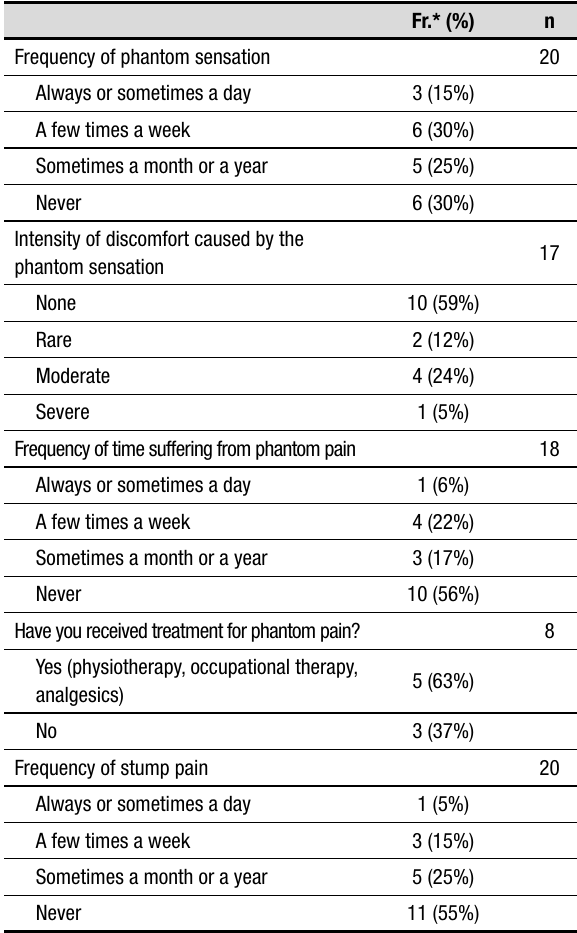
Table 2. Frequency and intensity of phantom sensation, phantom and stump pain among lower-limb amputees